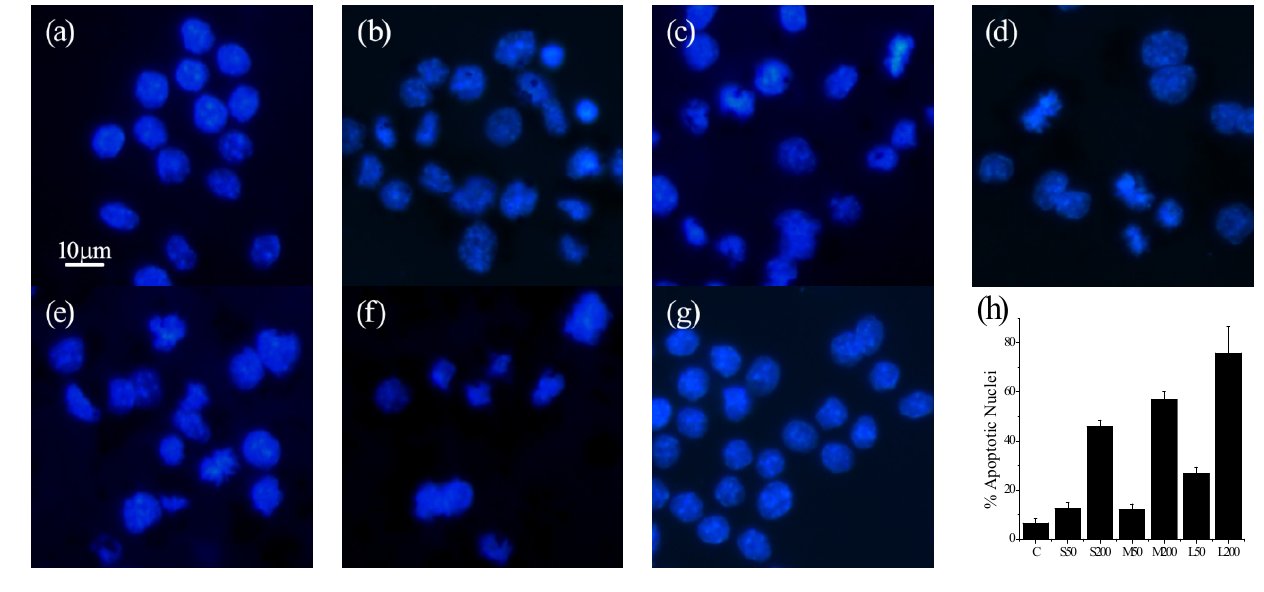
Figure 6. NCBs-induced nuclear damage in RAW264.7 cells. ( a ) 50 μ g·mL − 1 Printex 90; ( b ) 200 μ g·mL − 1 Printex 90; ( c ) 50 μ g·mL − 1 Printex G; ( d ) 200 μ g·mL − 1 Printex G; ( e ) 50 μ g·mL − 1 Flammruss 101; ( f ) 200 μ g·mL − 1 Flammruss 101; ( g ) Control. The scale bar corresponds to 10 μ m. ( h ) Quantitative calculation of the percent of apoptotic nucleic after treatment with different sized NCBs at various concentrations. C: control; S50: 50 μ g·mL − 1 Printex 90; S200: 200 μ g·mL − 1 Printex 90; M50: 50 μ g·mL − 1 Printex G; M200: 200 μ g·mL −